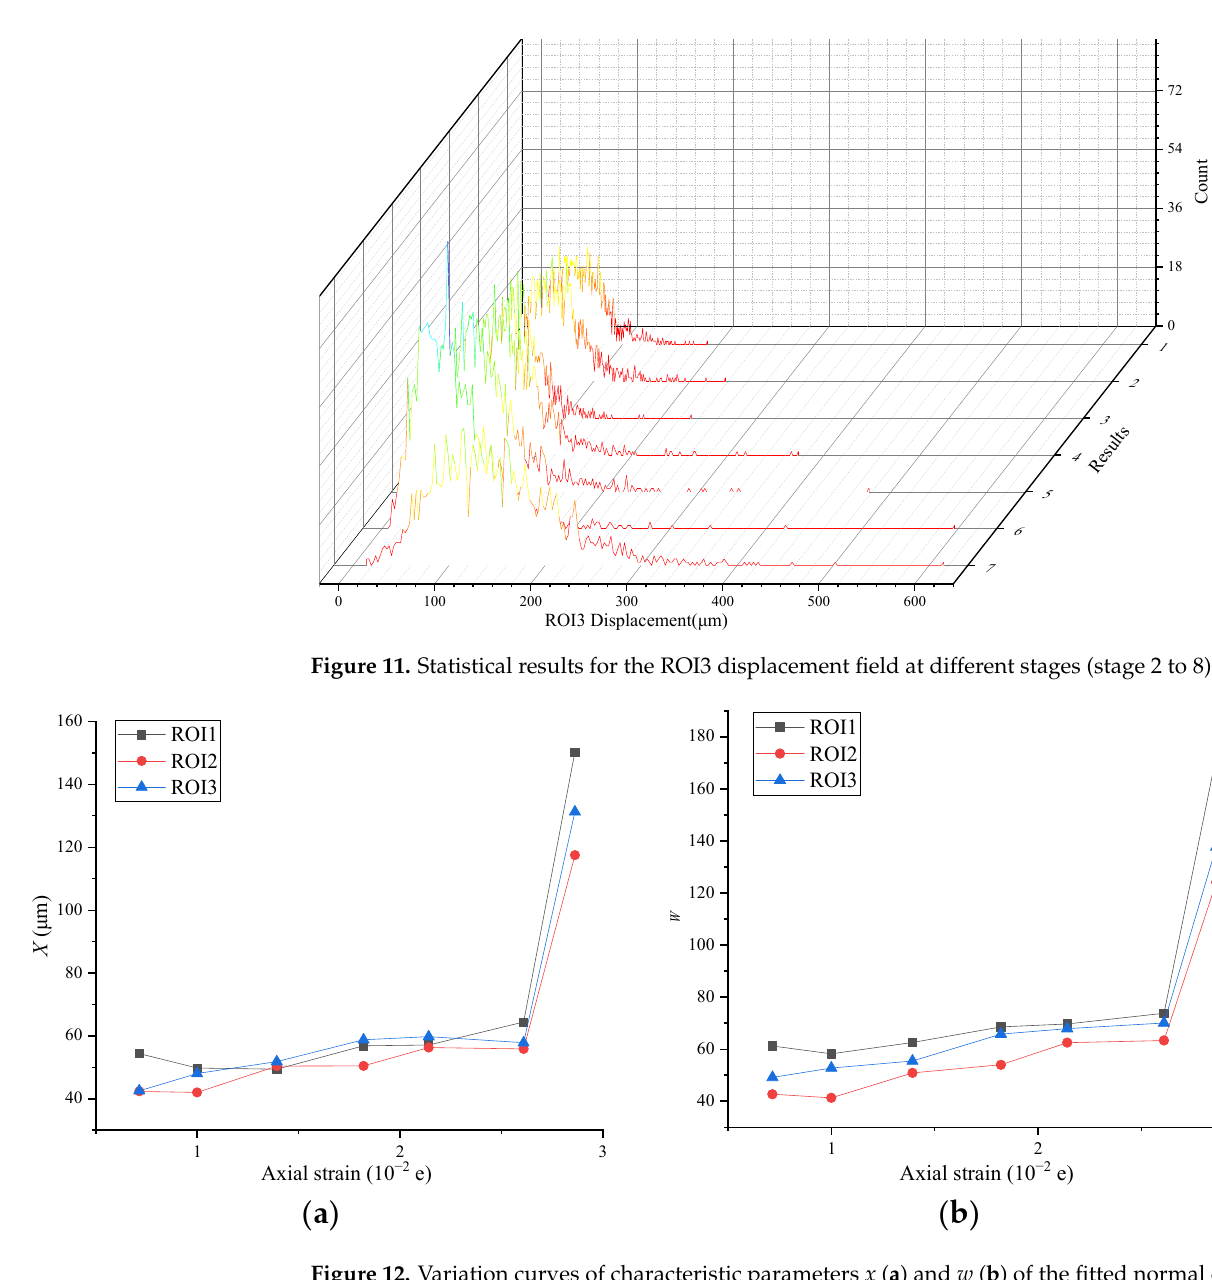
Figure 12. Variation curves of characteristic parameters x ( a ) and w ( b ) of the fitted normal distributions for ROI1-3.